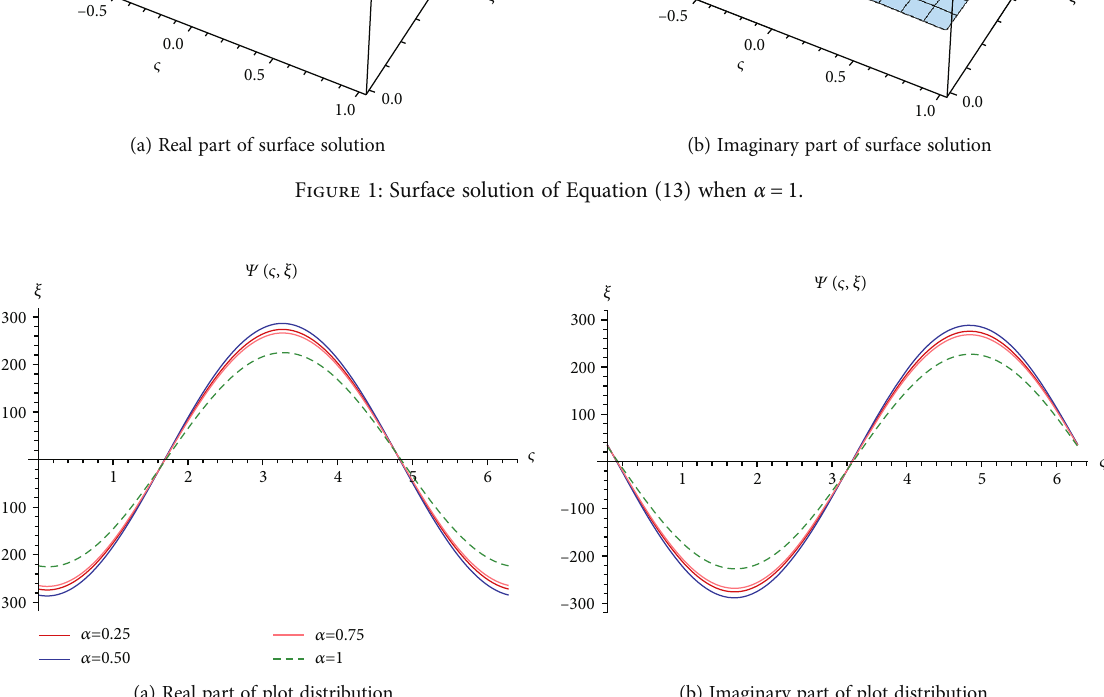
Figure 2: Plot distribution for di ff erent values of α at ξ = 1 .